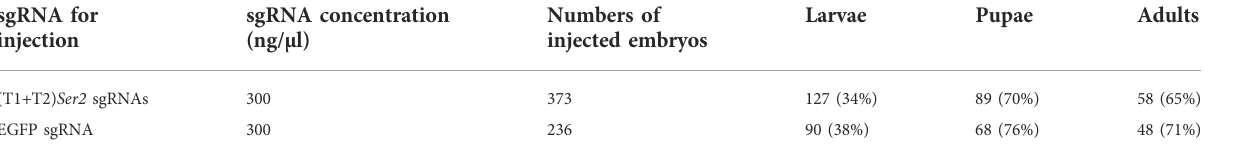
TABLE 1 Mutagenesis of the SlSer2 gene induced by injecting Cas9 mRNA and